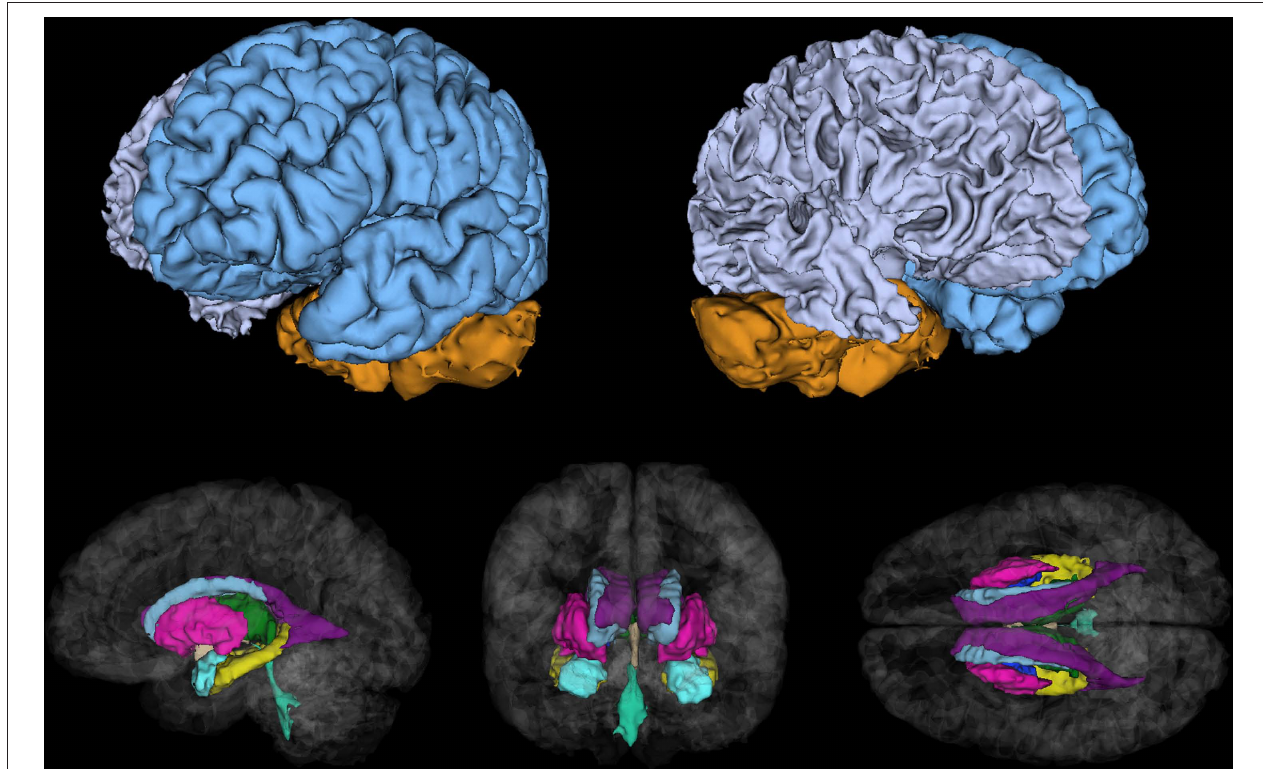
FIguRe 1 | Cerebral structures segmented in Freesurfer and investigated in the present study including gray/white matter and cerebellum (top), caudate (gray), pallidum (dark blue), thalamus (green), putamen (pink), hippocampus (yellow), amygdala (light blue), and lateral (purple), 3rd (beige) and 4th (turquoise) ventricles (bottom).